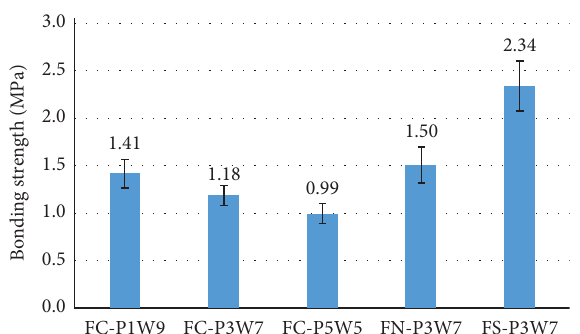
Figure 6: Comparison of bonding strengths of pine resin-based adhesives on concrete surfaces.